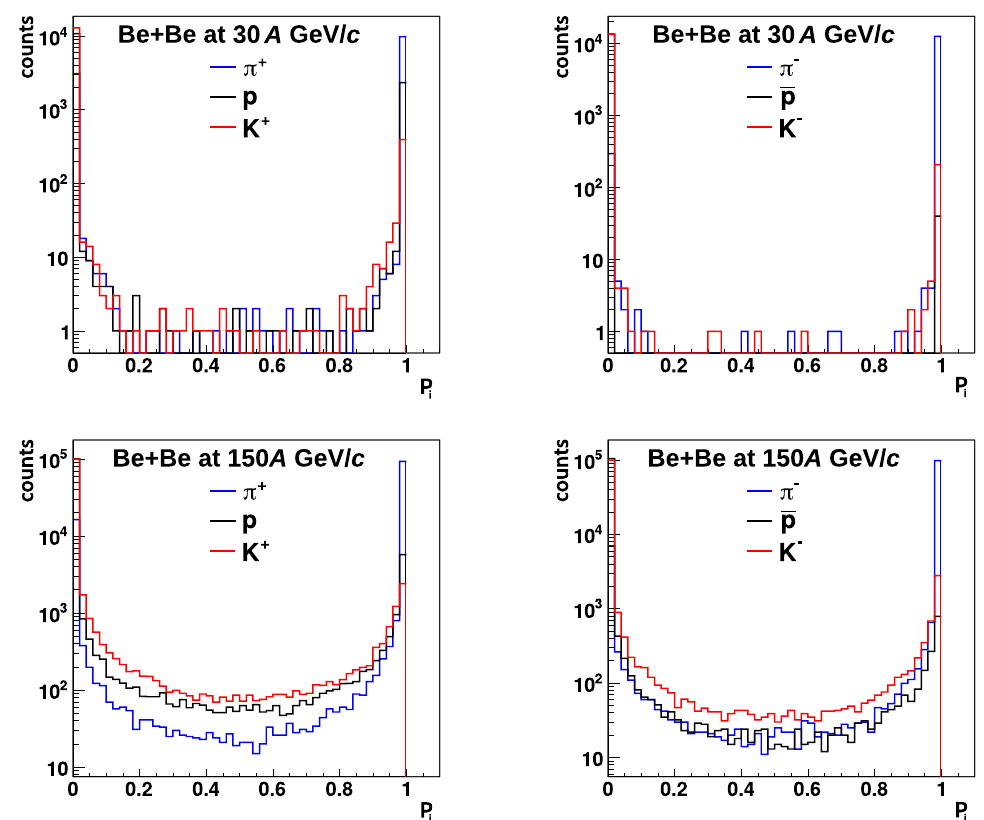
Fig. 14 Probabilityofatrackbeingapion, kaon, protonforpositively(left)andnegatively(right)chargedparticlesfrom tof -d E / d x measurements in PSD selected Be+Be collisions at 30 A (top) and 150 A GeV / c